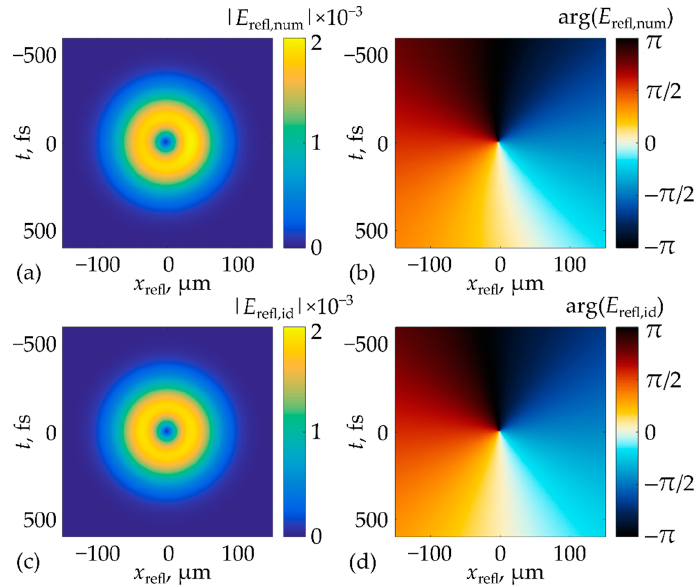
Figure 4. ( a ) Amplitude (absolute value) and ( b ) phase (argument) of the spatiotemporal envelope of the pulse generated upon reflection from the investigated structure calculated numerically; ( c ) amplitude and ( d ) phase of the envelope profile analytically calculated using Equation (7).